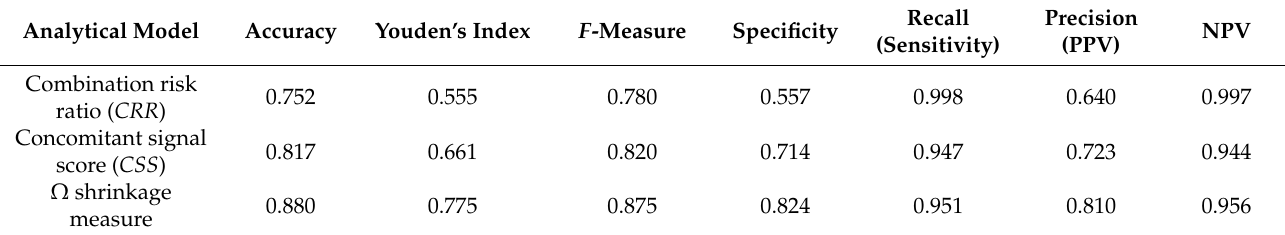
Table 3. Evaluation of the drug-drug interaction signals detected for n 111 ≥